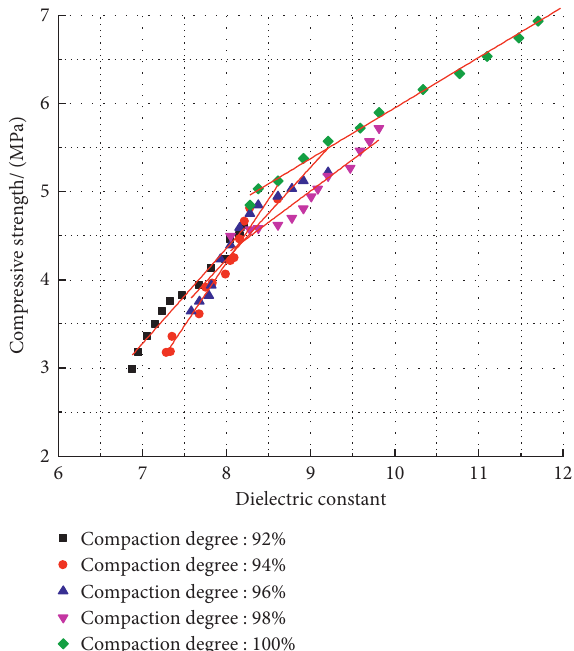
Figure 7: Relationship between the dielectric constant and strength of coarse